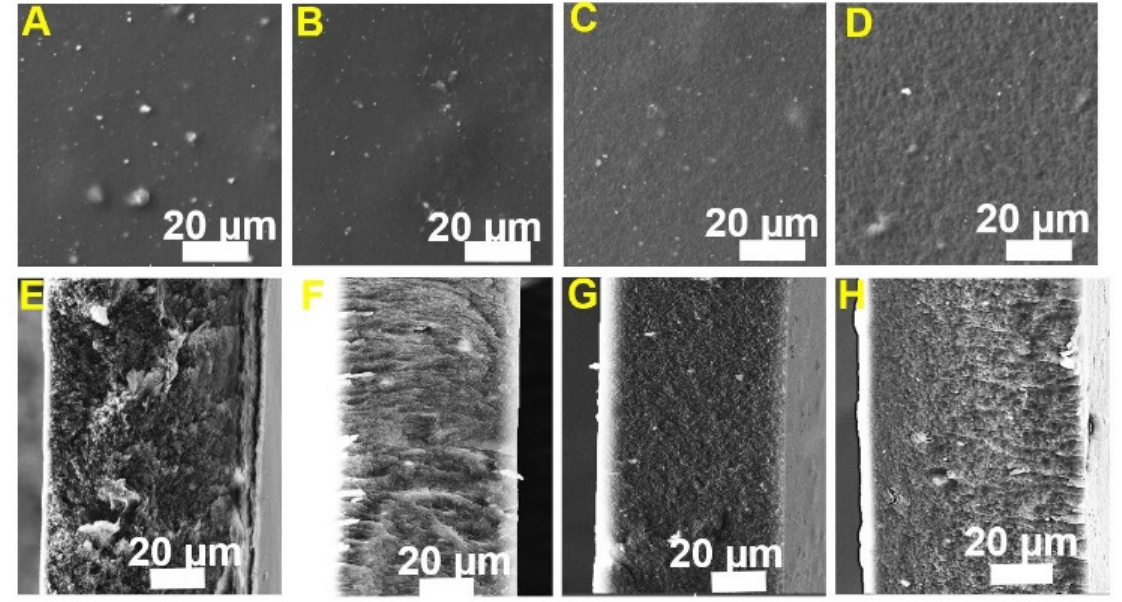
Figure 2. SEM images of the surface and their corresponding cross-section of the synthesized samples; ( A , E ) CTCeGO3, ( B , F ) CTCeGO5, ( C , G ) CTCeGO7 & ( D , H ) CTCeGO10 respectively.